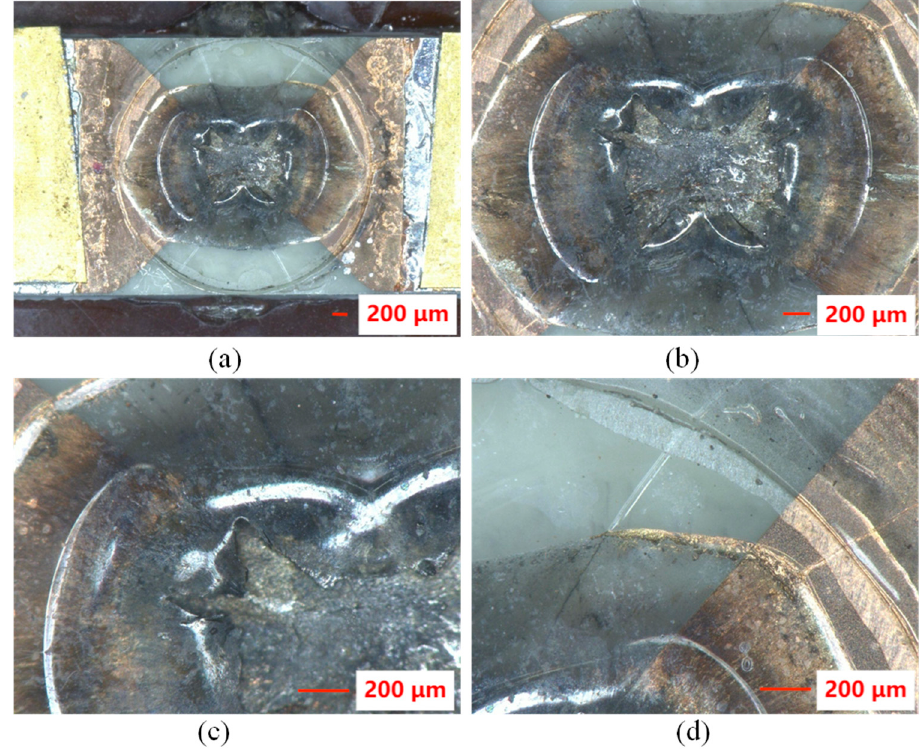
Figure 6. ( a ) Microscopic images of the flyer plate after the electric explosion test. ( b – d ) Enlarged Figure 6. (a) Microscopic images of the flyer plate after the electric explosion test. (b-d) Enlarged view of the polyimide film. view of the polyimide